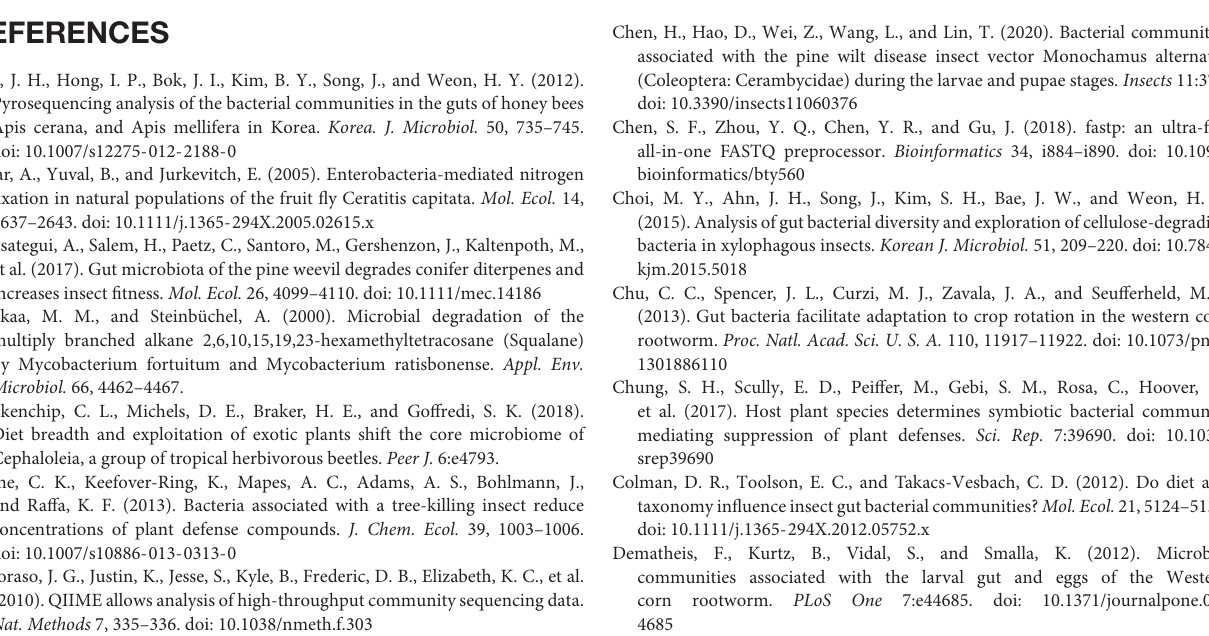
Supplementary Table 1 | Summary statistics for the Illumina Miseq runs for all samples. Supplementary Table 2 | Summary statistics for the qPCR runs for all samples. Supplementary Table 3 | Test data of Differences between groups in Mean qPCR values (Tukey’s multiple comparisons test). Supplementary Table 4 | Test data of Differences between groups in α - diversity. Supplementary Table 5 | Test data of ANOSIM analysis between groups for all samples. Supplementary Table 6 | PICRUST2 Functional annotations of KEGG pathway level 3 in all samples. Supplementary Table 7 | Metabolites identified in wood tissue samples and annotated information. Supplementary Table 8 | Metabolites identified in larval gut samples and annotated information. Supplementary Table 9 | Significance test of relative abundance in substances annotated in metabolism of terpenoids and polyketides (Kruskal–Wallis H -test). Supplementary Table 10 | Significance test of relative abundance in substances annotated in biosynthesis of other secondary metabolites (Kruskal–Wallis H